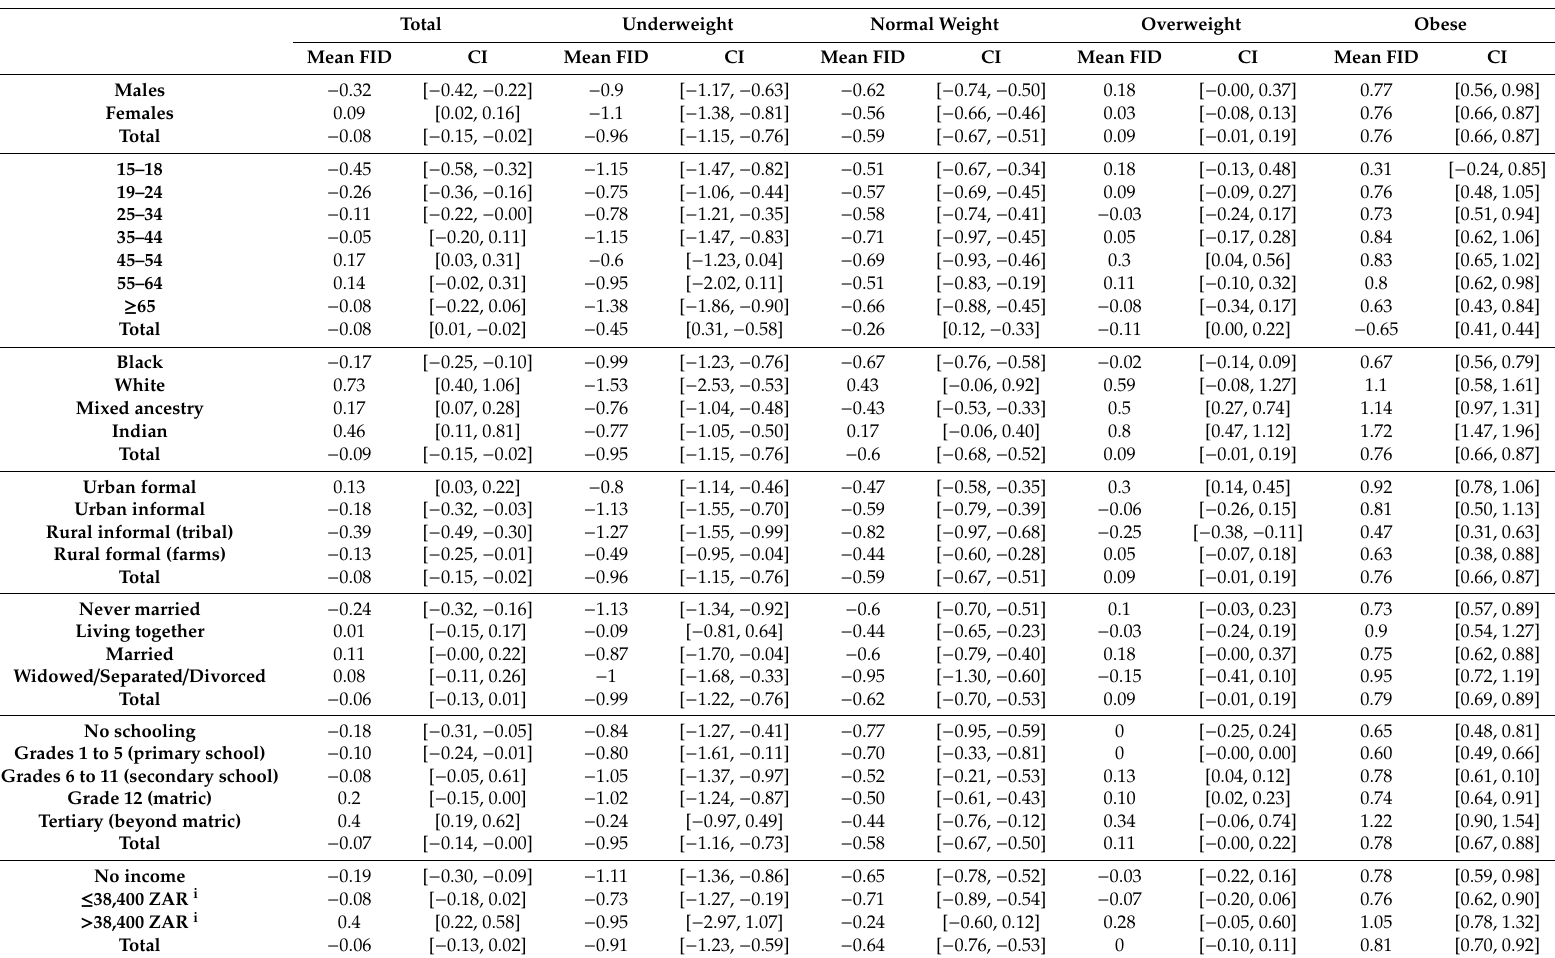
Table 1. Mean body size dissatisfaction / feel–ideal discrepancy (FID) scores of adult South Africans aged 15 years and older, SANHANES 2012 1